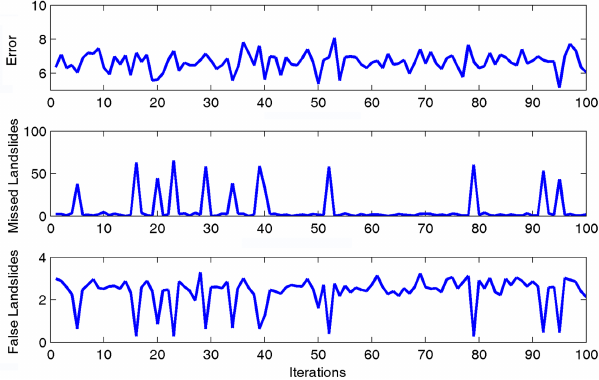
Fig. 7. (a) Total error; (b) Error of missed landslides; and (c) Error of false landslides of the model for 100 simulations with different combinations of 70% training and 30% validation